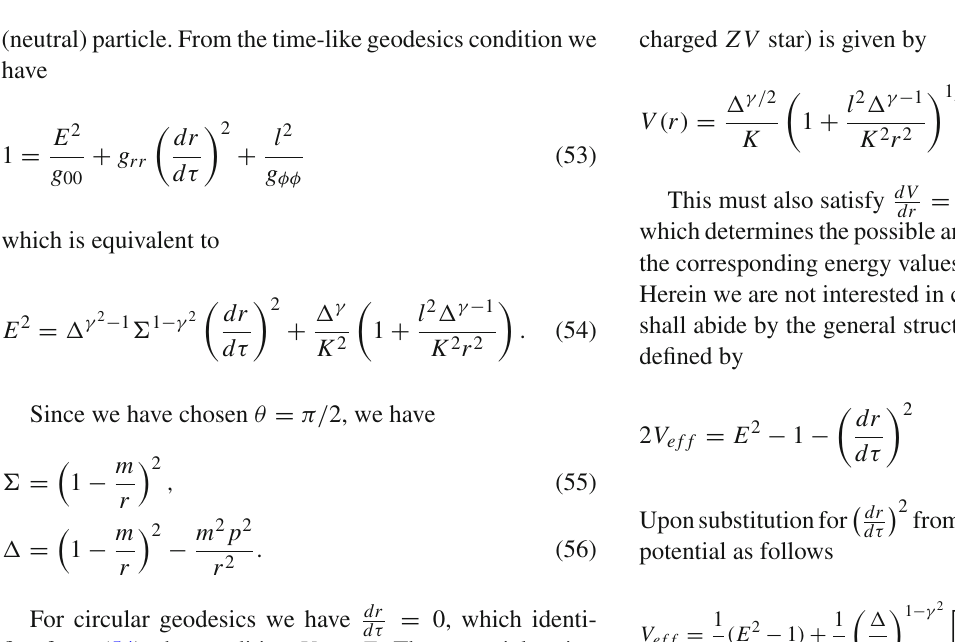
Fig. 8 Overlapping plots of δ versus x for all types of stars in the Table 1, for γ = 0 . 6 (solid line) , γ = 0 . 8 (dotted line) and γ = 1 (dashed line), for comparison. Plots are generated for the charged ZV case for a particular value of p = q = 1 √